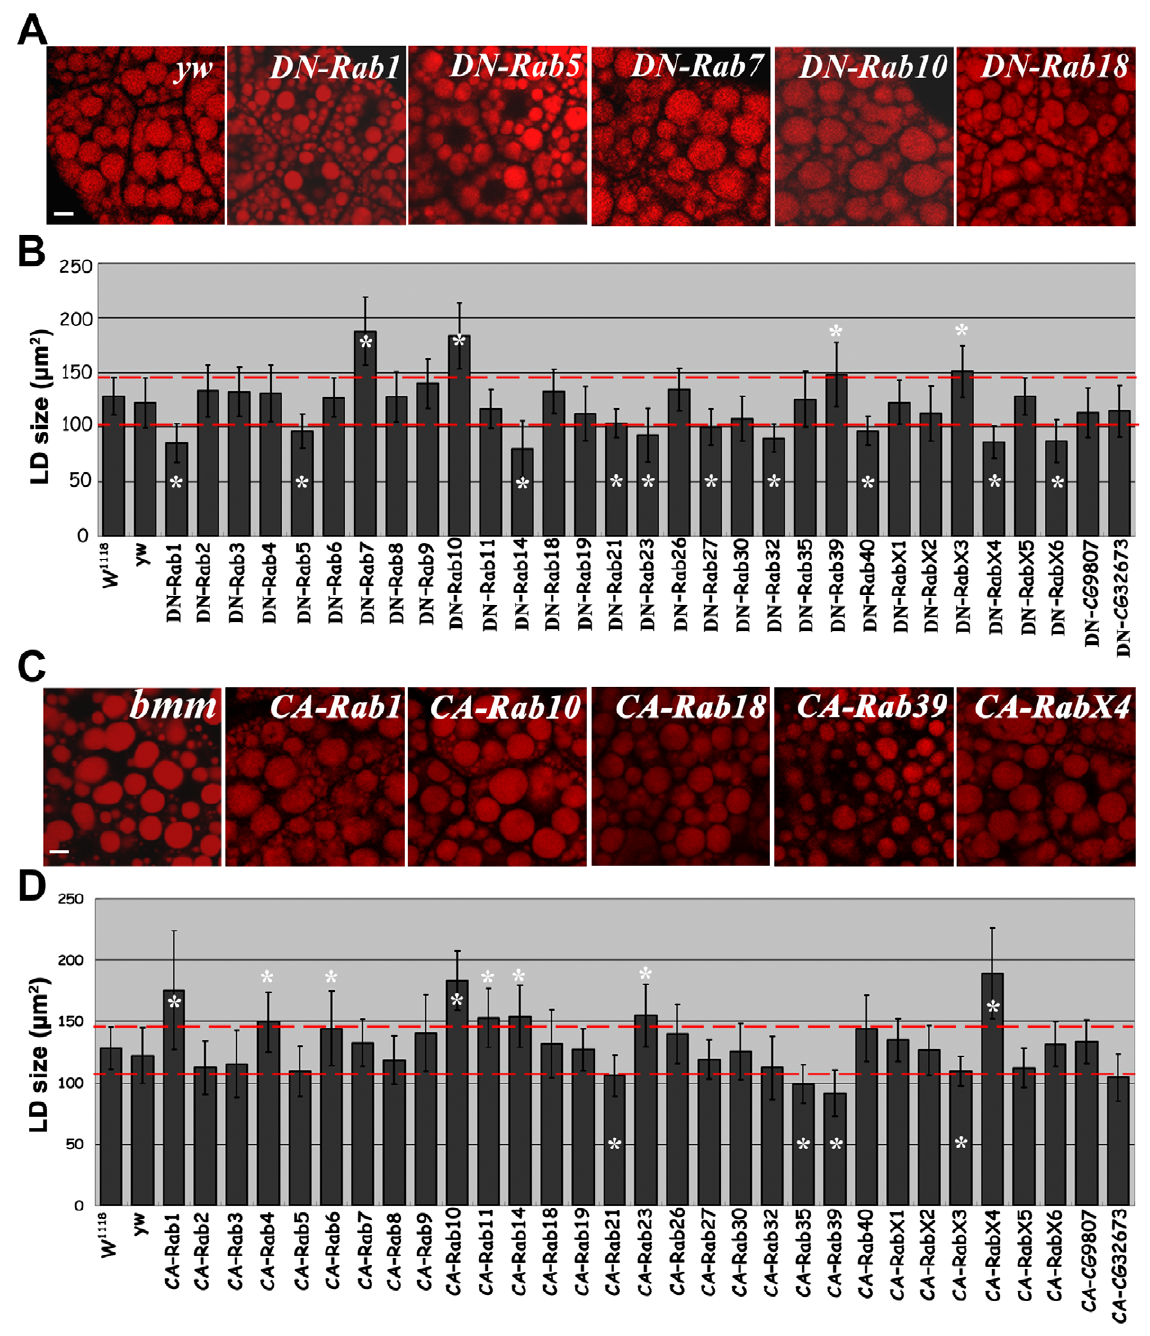
Figure 1. Genetic screen for Rabs that affect the size of lipid droplets. (A) Nile red staining of lipid droplets in wandering stage third instar larval fat body cells. Dominant-negative (DN) Rab expression reduces (DN-Rab1 and DN-Rab5) or increases (DN-Rab7 and DN-Rab10) lipid droplet size. Expressing DN-Rab18 does not affect the size of lipid droplets. Scale bar: 10 m m. (B) Quantification of the effects of all DN-Rabs. The error bars represent the standard deviation. Red dashed lines indicate the average variation in lipid droplet size in controls. *: P , 0.01. (C) Nile red staining of lipid droplets in wandering stage third instar larval fat body cells. Constitutive-active (CA) Rab expression reduces (CA-Rab39) or increases (CA-Rab1, CA-Rab10, and CA-RabX4) lipid droplet size. Expressing CA-Rab18 does not affect the size of lipid droplets. bmm mutant was included as a comparison. Scale bar: 10 m m. (D) Quantification of the effects of all CA-Rabs. The error bars represent the standard deviation. Red dashed lines indicate the average variation in lipid droplet size in controls. *: P , 0.01. doi:10.1371/journal.pone.0032086.g001 that the regulation of lipid droplet size may share some suggesting that ltd and rb act similarly in regulating lipid storage (Fig. 3B). components with, but may not be identical to, the eye pigment granule biogenesis pathway. Furthermore, rb;ltd double mutants Changes in lipid droplet size in ltd , ca , and rb mutants may have the same small lipid droplet phenotype as rb single mutant, reflect changes in lipid levels. We measured larval TAG levels and